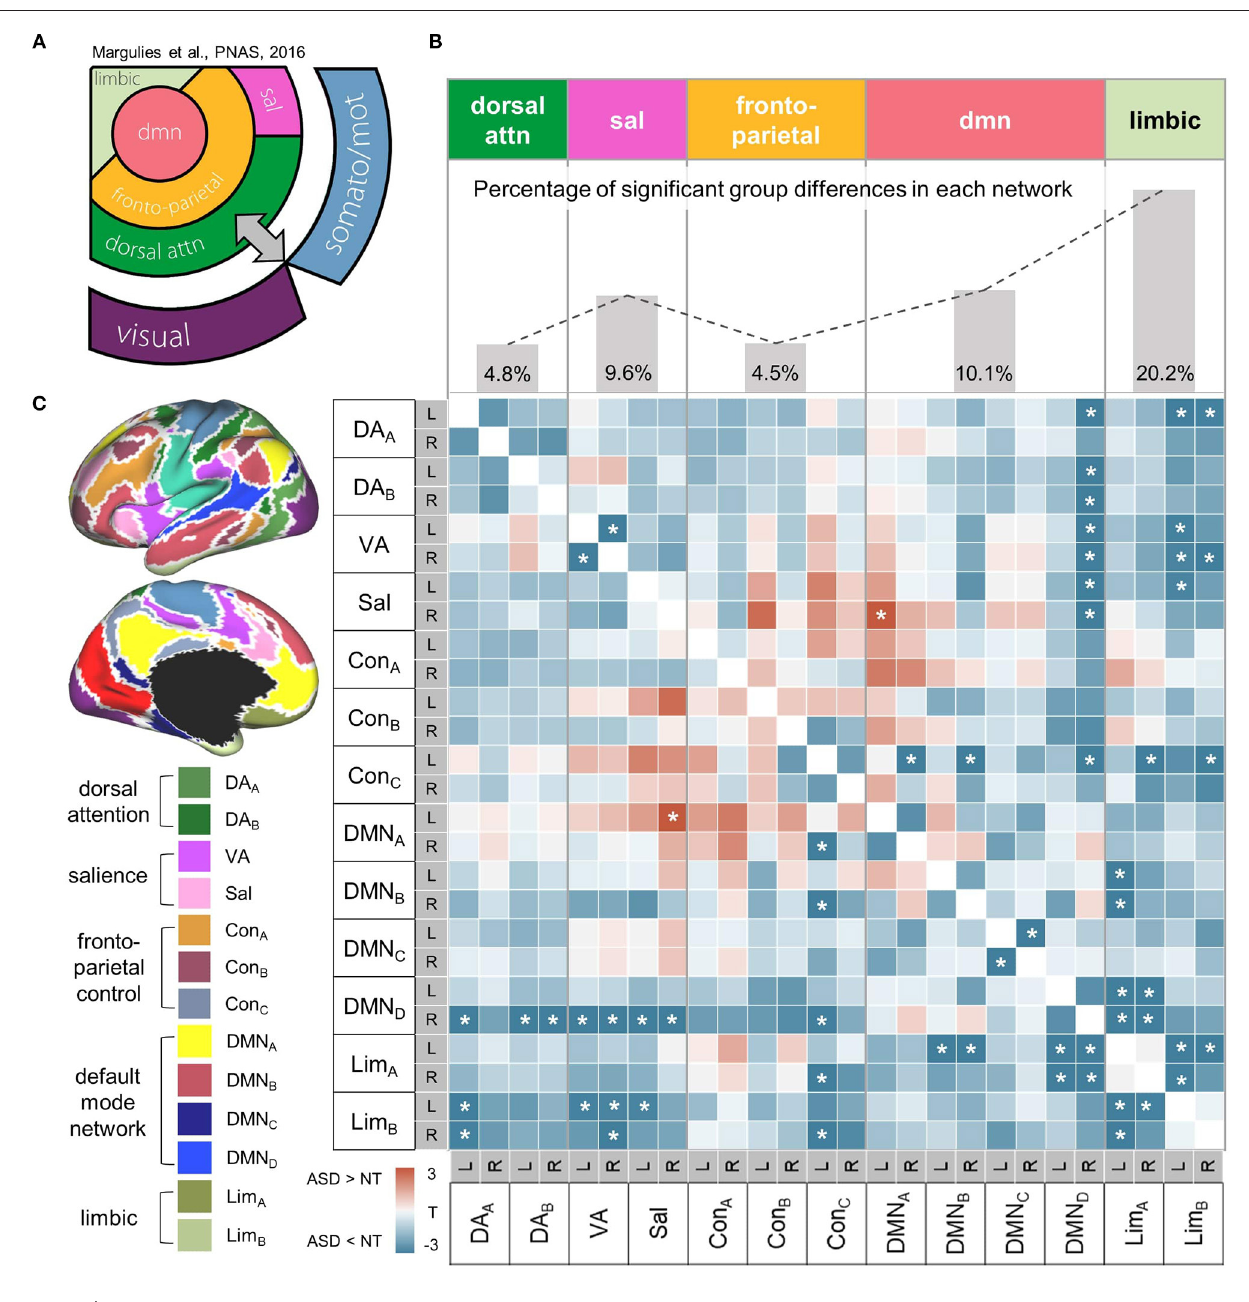
connectivity. The significance of these parcel-wise tests was corrected for multiple comparisons using a false discovery rate (FDR)